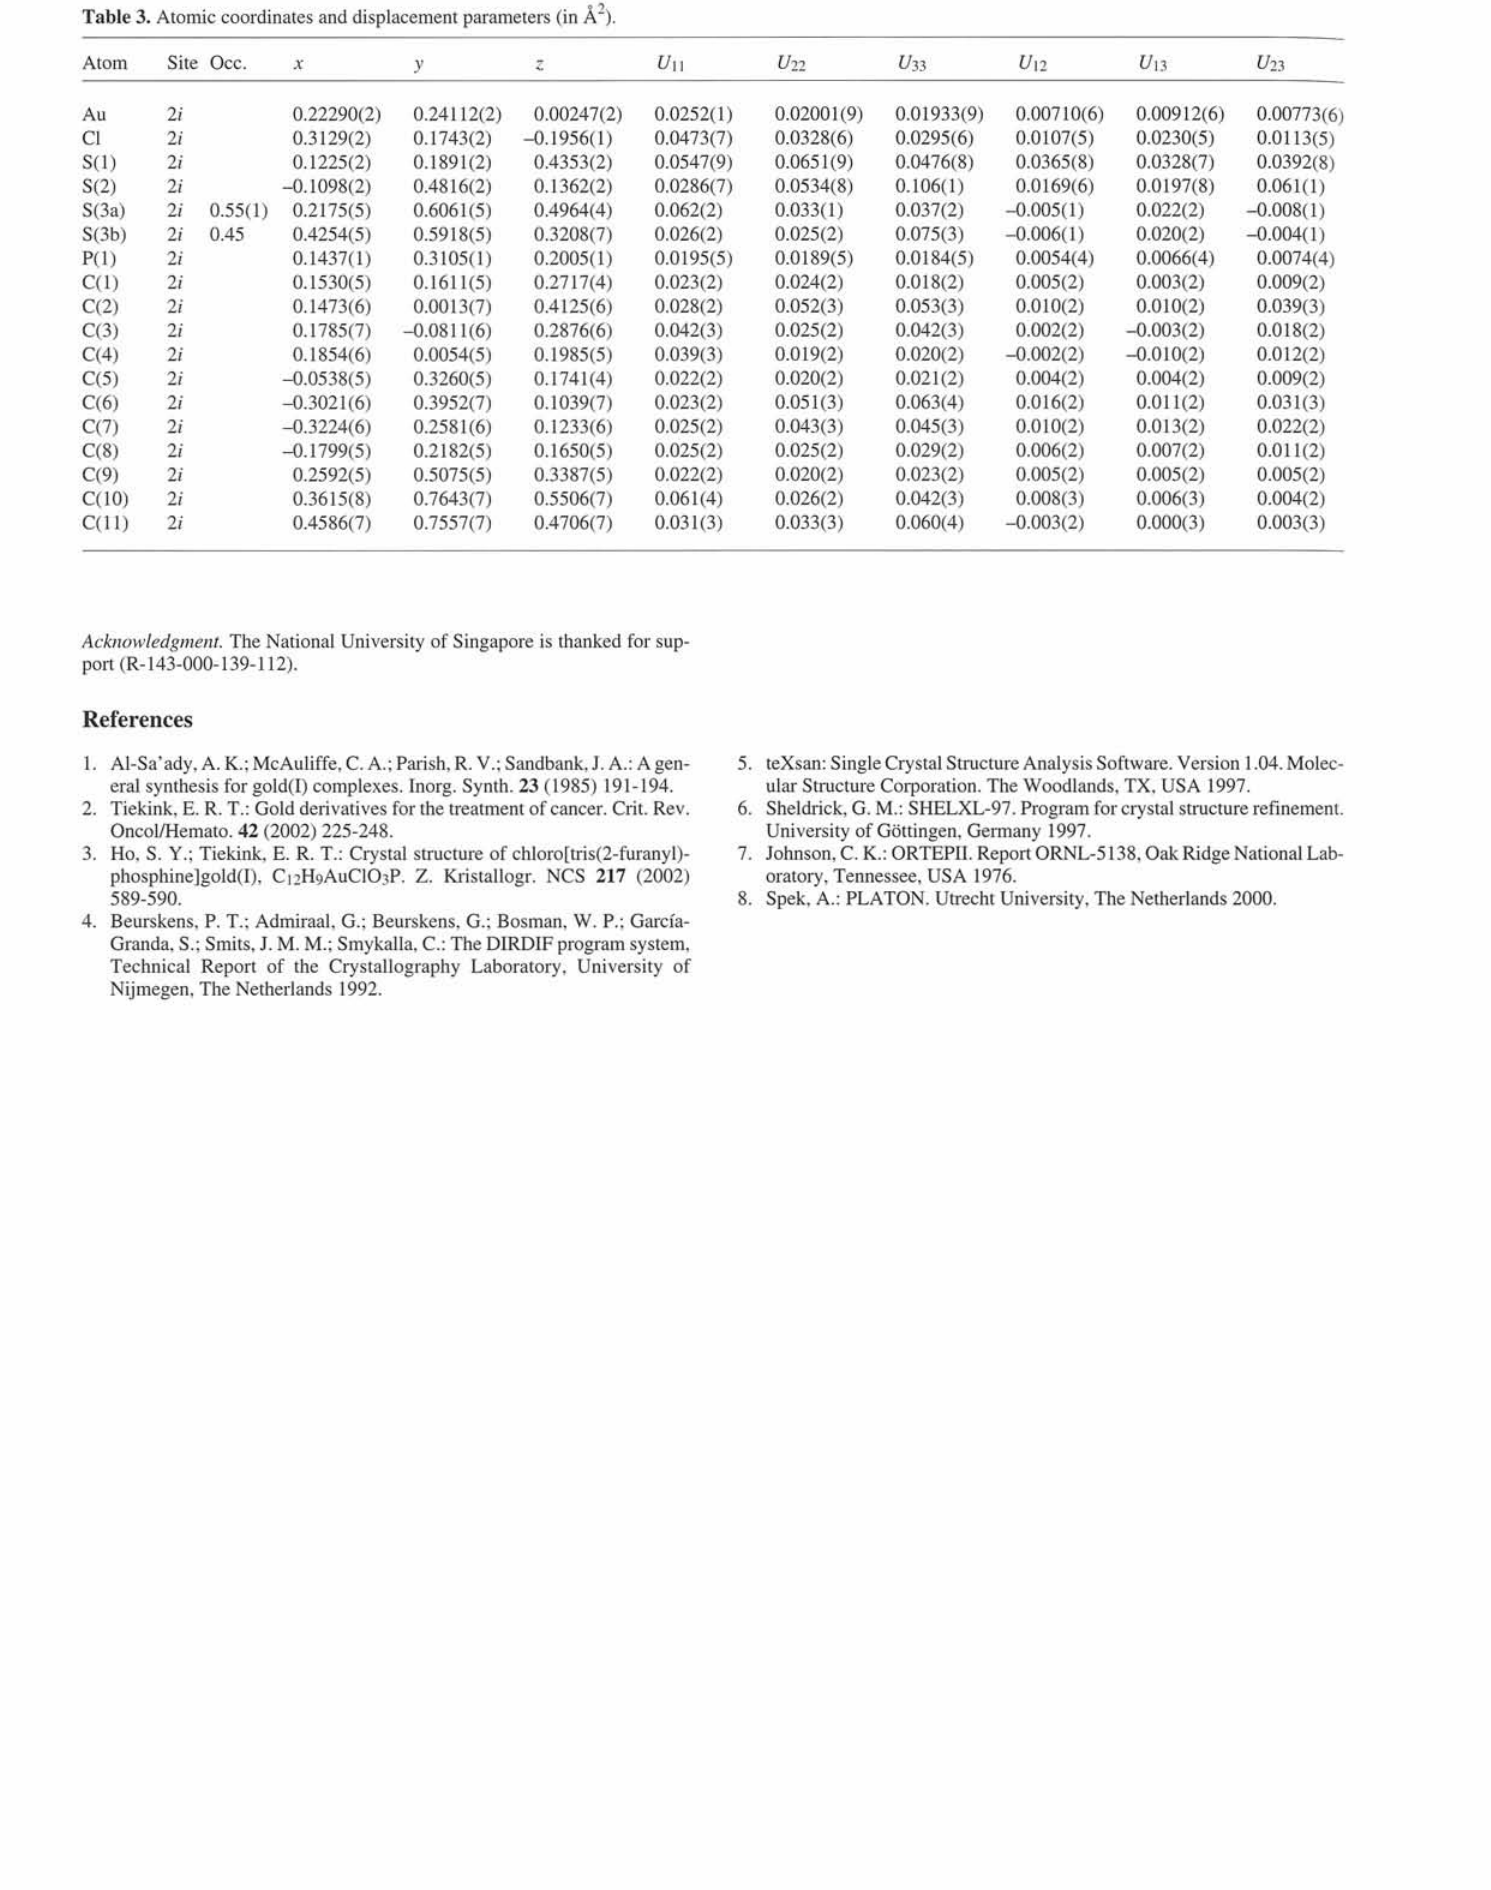
Table 3. Atomic coordinates and displacement parameters (in À 1